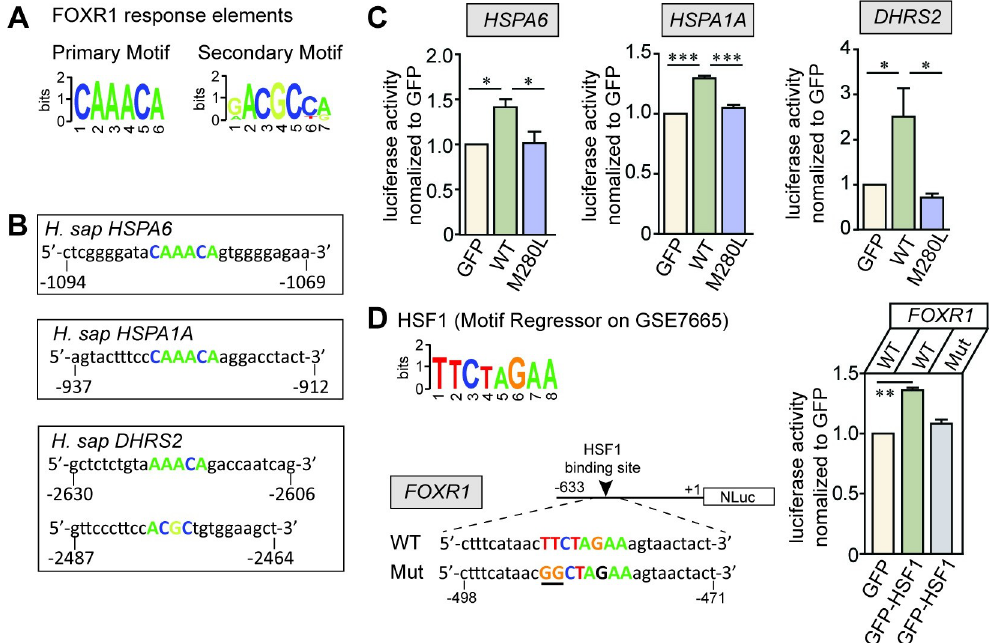
Fig 5. Human DNA binding-site motifs bound by FOXR1. (A) FOXR1 response elements showing consensus primary and secondary sequences bound by FOXR1 (adapted from [14]). (B) Putative FOXR1 response elements are denoted in the promoters of three of the top-regulated FOXR1-targeted genes: HSPA6 , HSPA1A and DHRS2 . (C) Dual luciferase reporter assays where GFP control, FOXR1 WT or M280L were co-transfected into HEK293T cells with the corresponding HSPA6 , HSPA1A and DHRS2 luciferase reporters. Data are plotted as luciferase activity normalized to GFP control. One-way ANOVA Tukey’s multiple comparisons test (n = 3 independent experiments, � p < 0.05, ��� p < 0.0002). (D) Consensus primary sequences bound by HSF1. The putative HSF1 response elements are denoted in the promoter of FOXR1 . Dual luciferase reporter assays where GFP control or GFP-HSF1 were co-transfected in HEK293T cells with corresponding FOXR1 WT or Mut luciferase reporter. FOXR1 mutant (Mut) consists of the HSF1 response elements in FOXR1 where the two TT residues in FOXR1 WT are mutated to GG (underlined). Data was plotted as luciferase activity normalized to GFP control. One-way ANOVA Tukey’s multiple comparisons test (n = 3 independent experiments, �� p =